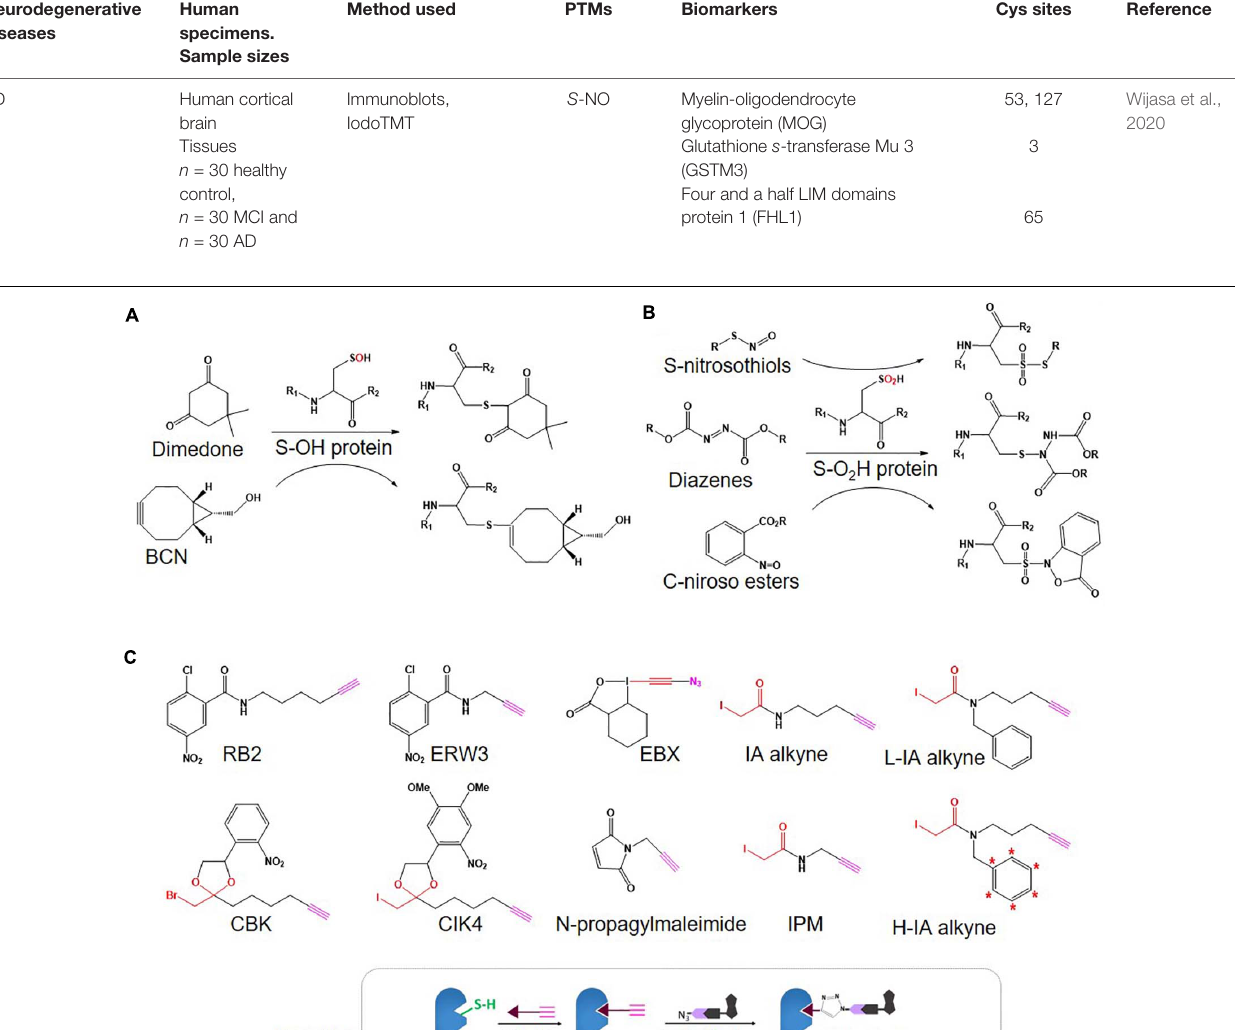
• Heavy isotope incorporation: for duplex analysis including stable isotope labeling by amino acids in cell culture (SILAC), isotopes of IA-alkyne tags (Abo et al., 2018) ( Figure 5C ), light and heavy isotopic biotin-azide linkers ( Figure 7 ); for triplex analysis including reductive dimethylation rdTOP-ABPP (Yang et al., 2018); and multiplex including isobaric tags (iTRAQ, TMT). The synthesis of isotope containing cleavable biotin tags [ L - Valine-N-Fmoc ( 13 C 5 , 15 N 1 )] is usually expensive and low yield, but recently, a more cost-effective version of light and heavy isotopes of IA-alkyne tags ( Figure 5C ) has been developed (Abo et al., 2018). The availability of these three crucial